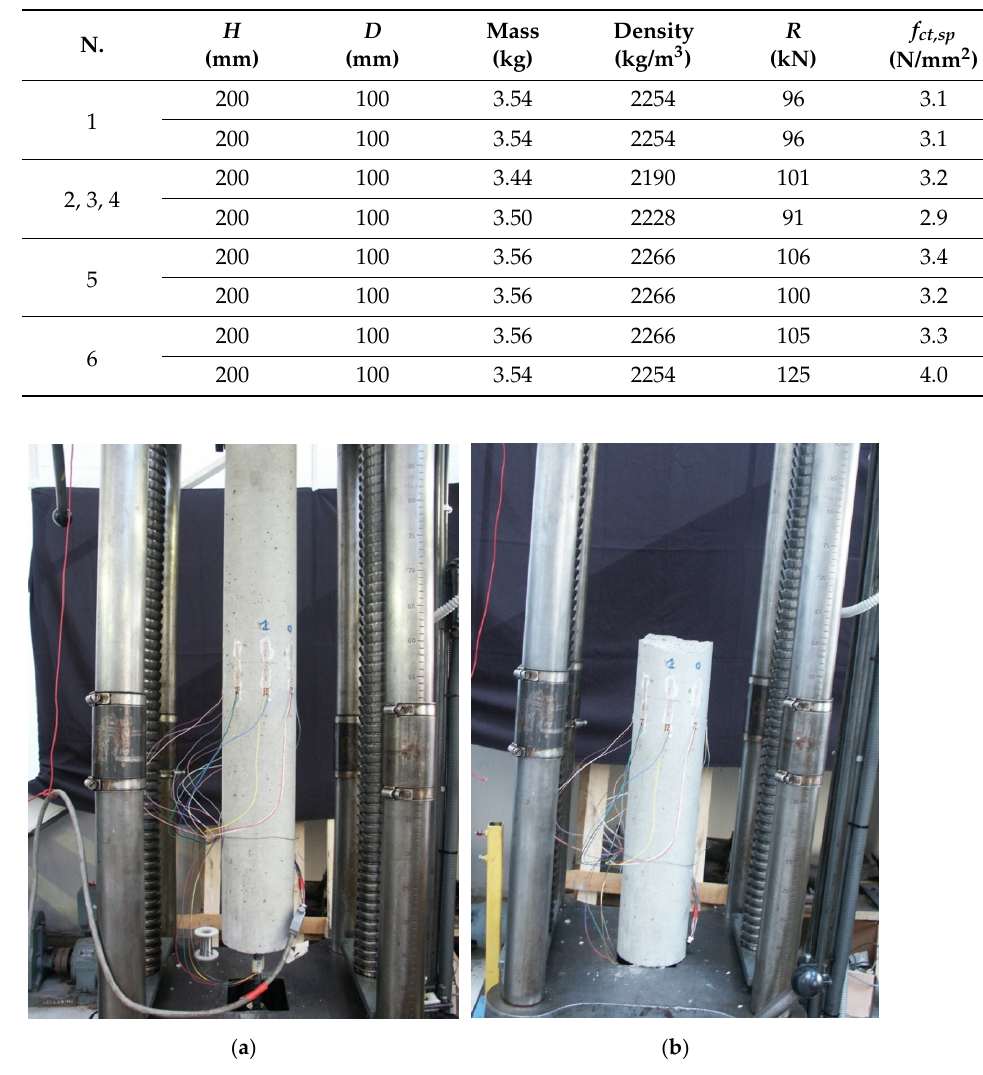
Figure 8. Instrumented cylindrical r.c. tie used for direct tensile tests: ( a ) at the beginning of the test; ( b ) after failure.